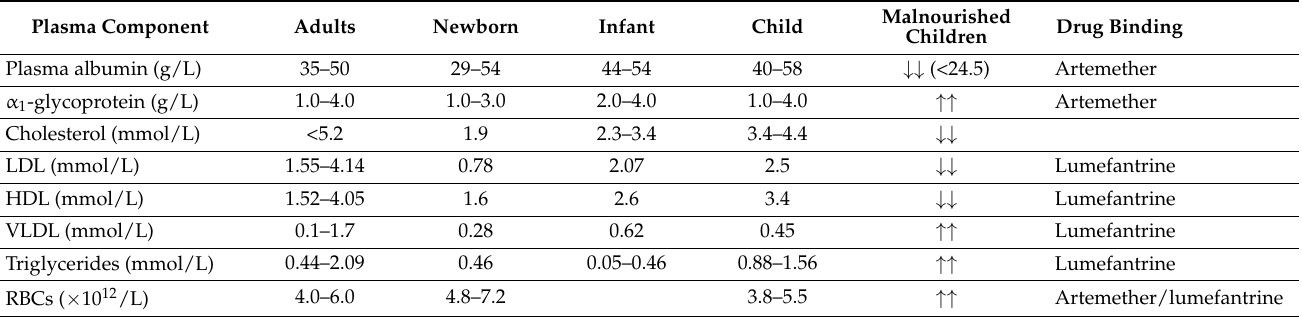
Table 1. The concentrations of selected plasma components in different population